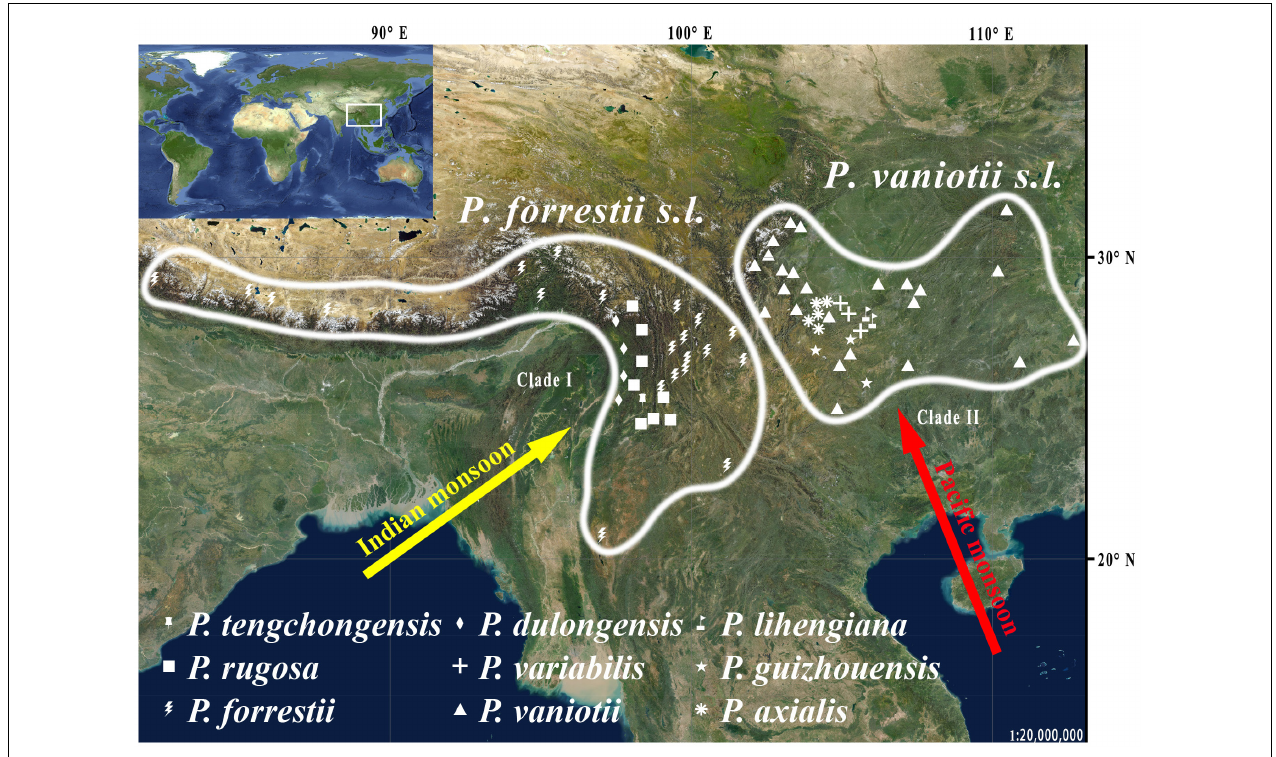
FIGURE 2 | Distribution of the nine nominal species within Paris section